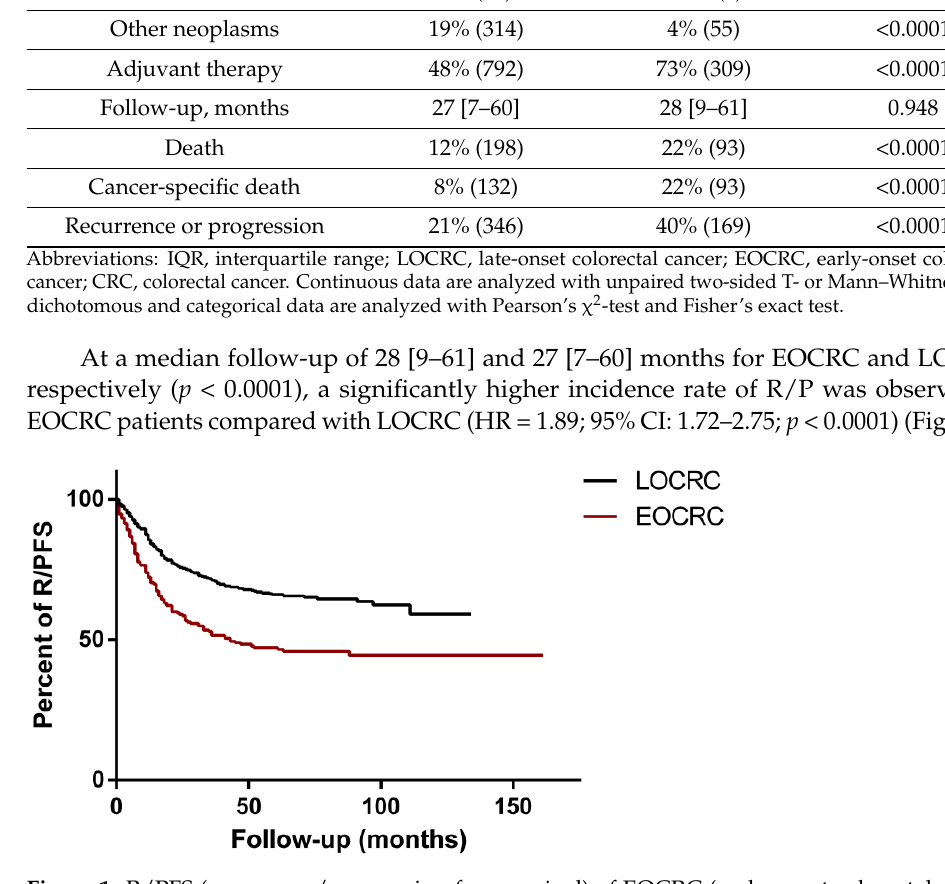
Figure 1. R/PFS (recurrence/progression-free survival) of EOCRC (early-onset colorectal cancer) (red line) and LOCRC (late-onset colorectal cancer) (black line) patients. Data were compared with